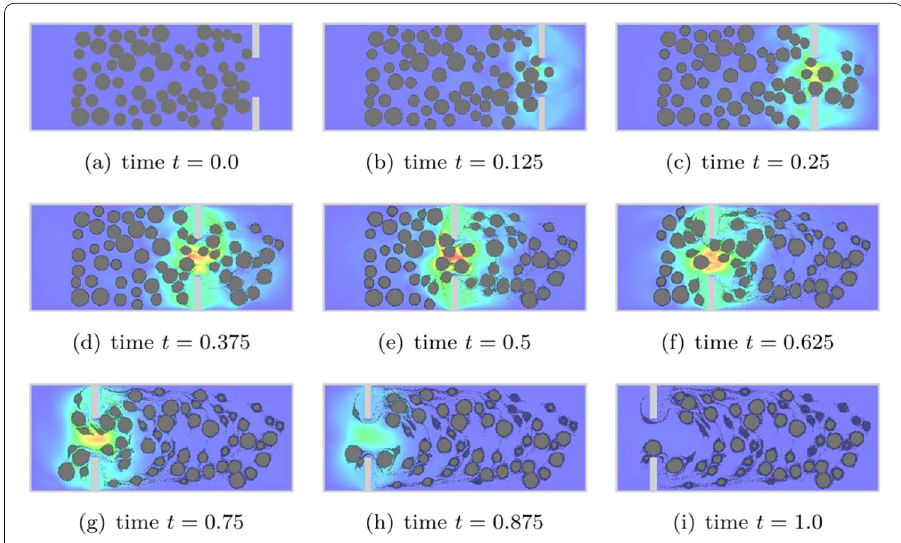
Fig. 15 Gastric disintegration of food boluses: time series of the obtained results with magnitude of the velocity field ranging from 0 . 0 (blue) to 120 . 0 (red)